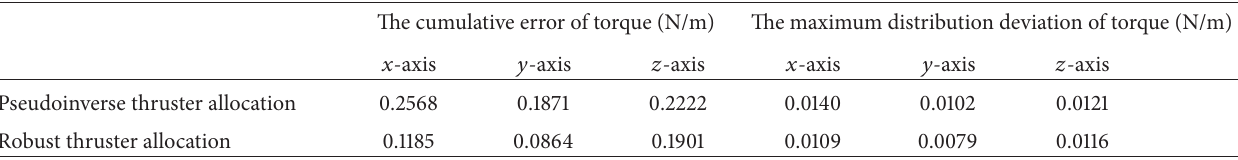
Table 2: The simulation result when the control efficiency matrix is with the uncertainty of 10%. The cumulative error of torque (N/m) The maximum distribution deviation of torque (N/m) 𝑥 -axis 𝑦 -axis 𝑧 -axis 𝑥 -axis 𝑦 -axis 𝑧